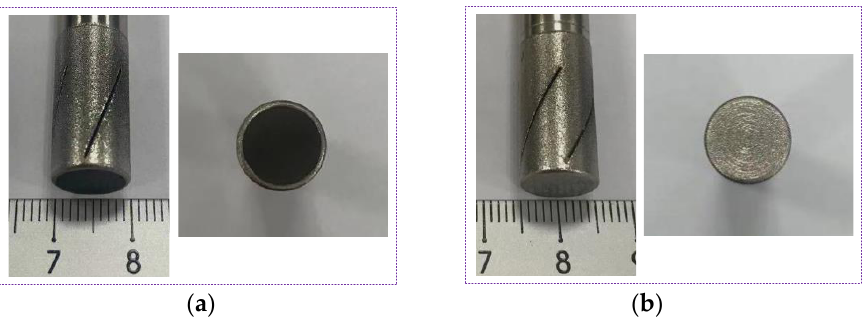
Figure 5. ECMG of the cathode tool: ( a ) in rough machining, ( b ) in finish machining. The test material was Ti6Al4V titanium alloy (mass fraction ratio Ti: 89.335%, Al: 6%, V: 4%, Fe: 0.3%, O: 0.2%, C: 0.1%, N: 0.05%, H: 0.015%). In order to select reasonable ECMG parameters, an